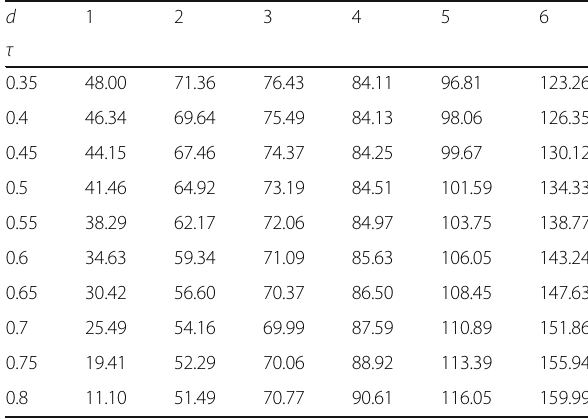
Table 7 The unequal distance of nodes (MPSK)